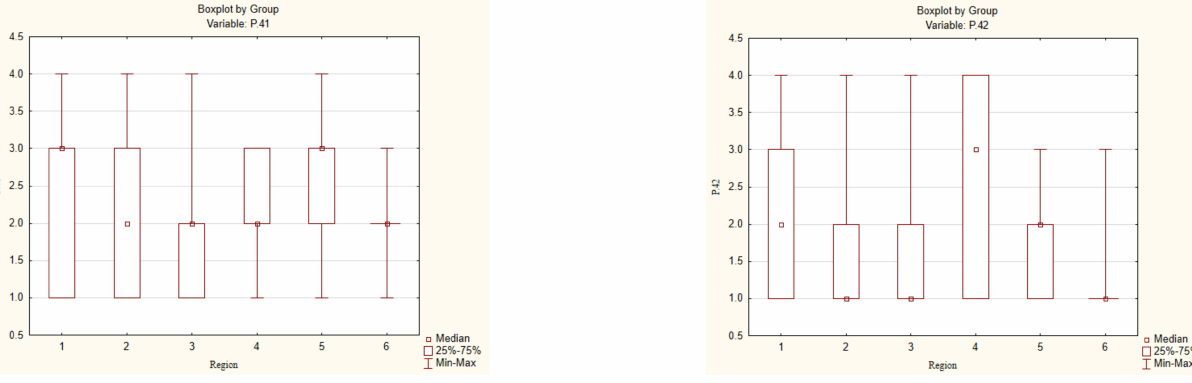
Figure 14. Box and whisker charts by practices P41 (Buying ecomark-appliances), P42 (Choosing goods with their CO 2 emission in mind (carbon footprint)), from category